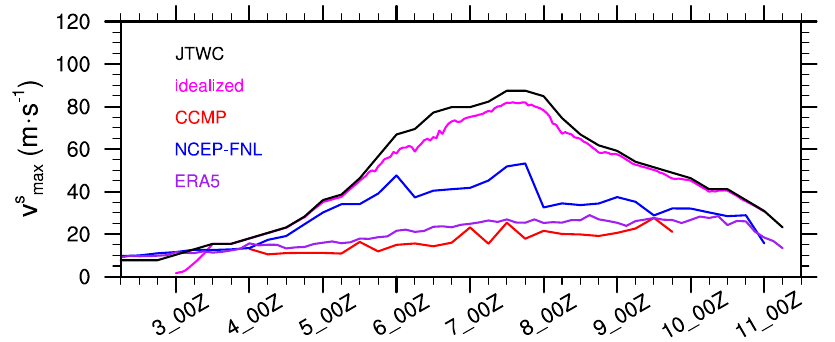
Figure 5. Time series of maximum surface wind during super-typhoon Haiyan. The data sources include the best-track data of JTWC (the maximum sustained wind is used), idealized wind vortex, satellite wind of CCMP, analysis wind of NCEP-FNL, and reanalysis wind provided by ERA5. Two atmospheric analysis/reanalysis give correct central position of tropical cyclone NCEP-FNL is 50 m · s − 1 , although still weaker than the idealized wind vortex (80 m · s − 1